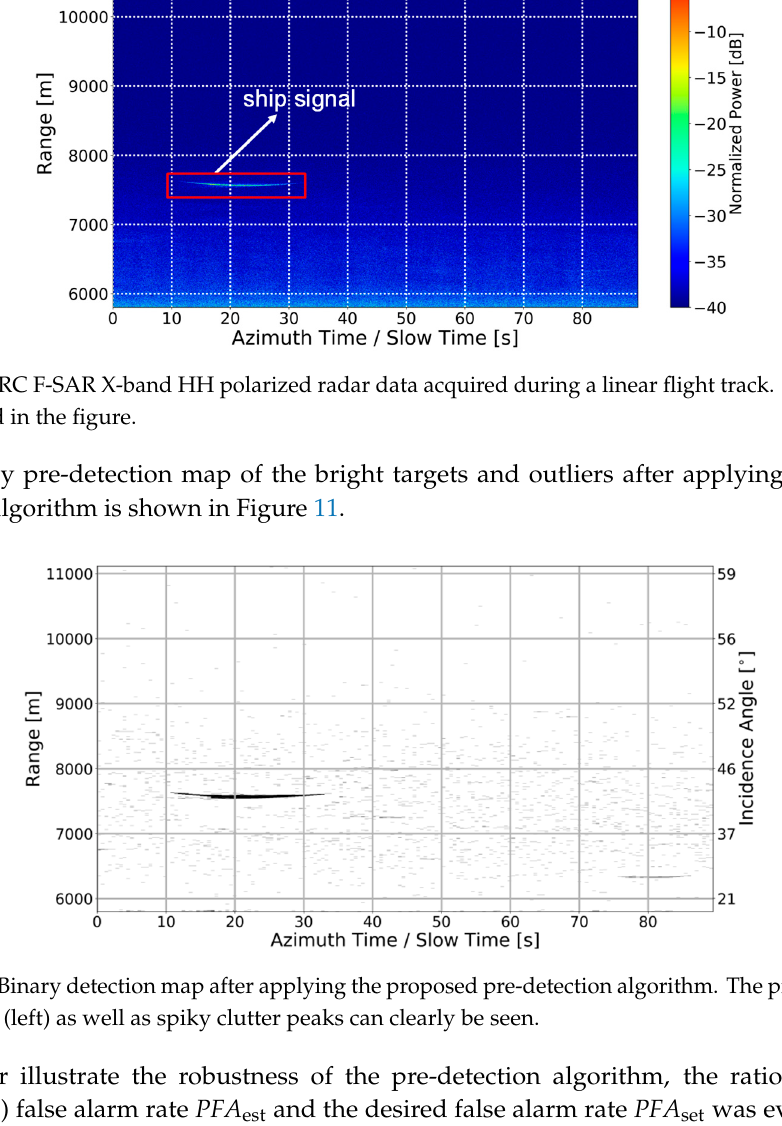
Figure 12. Ratio of the false alarm rates over range for X-band HH (top), VV (middle) and HV (bottom) polarization before (blue) and after pre-detection and target cancellation (red). Note that a ship target is present at around 42 ° incidence angle.